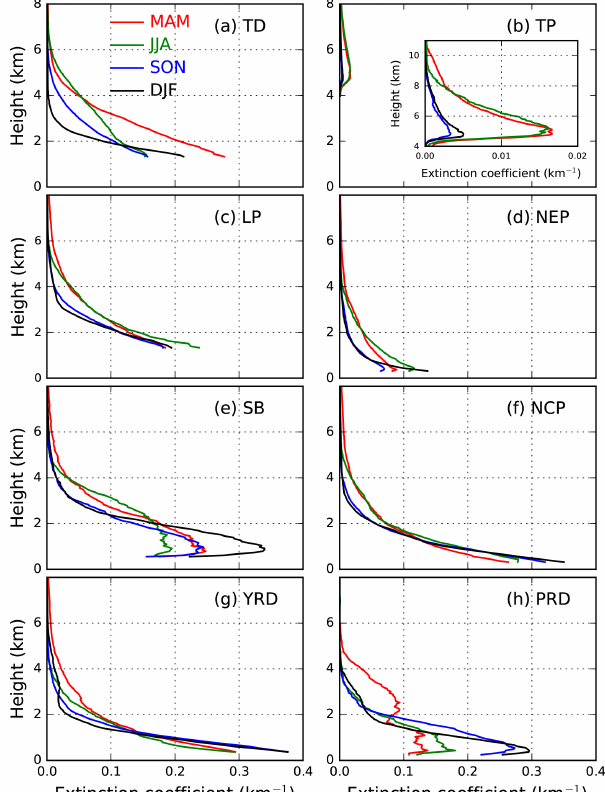
Figure 9. Classification of the AERONET sites representing dust (SACOL in spring), anthropogenic aerosols (Beijing and Taihu in summer) and aerosols of mixed types (Beijing in spring).